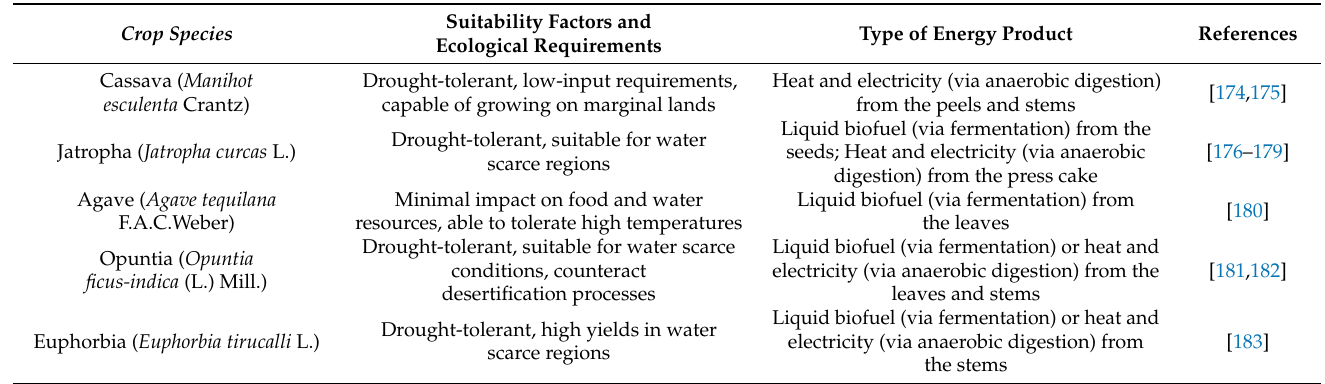
Table 3. A list of potential candidates to be established on MADs based on their suitability factors and ecological